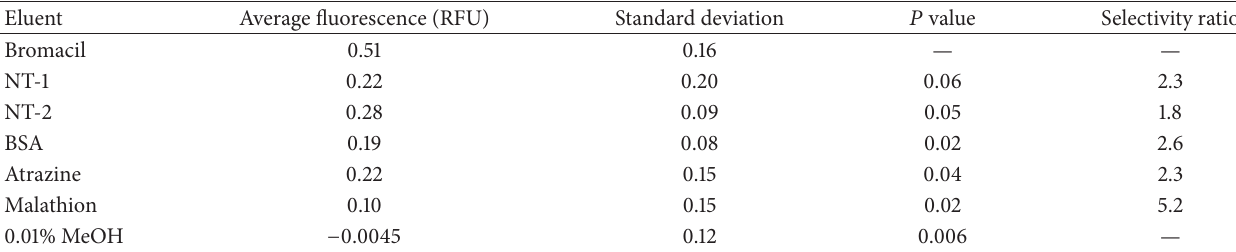
Table 3: Cross-reactivity data of R13.2 ssDNA